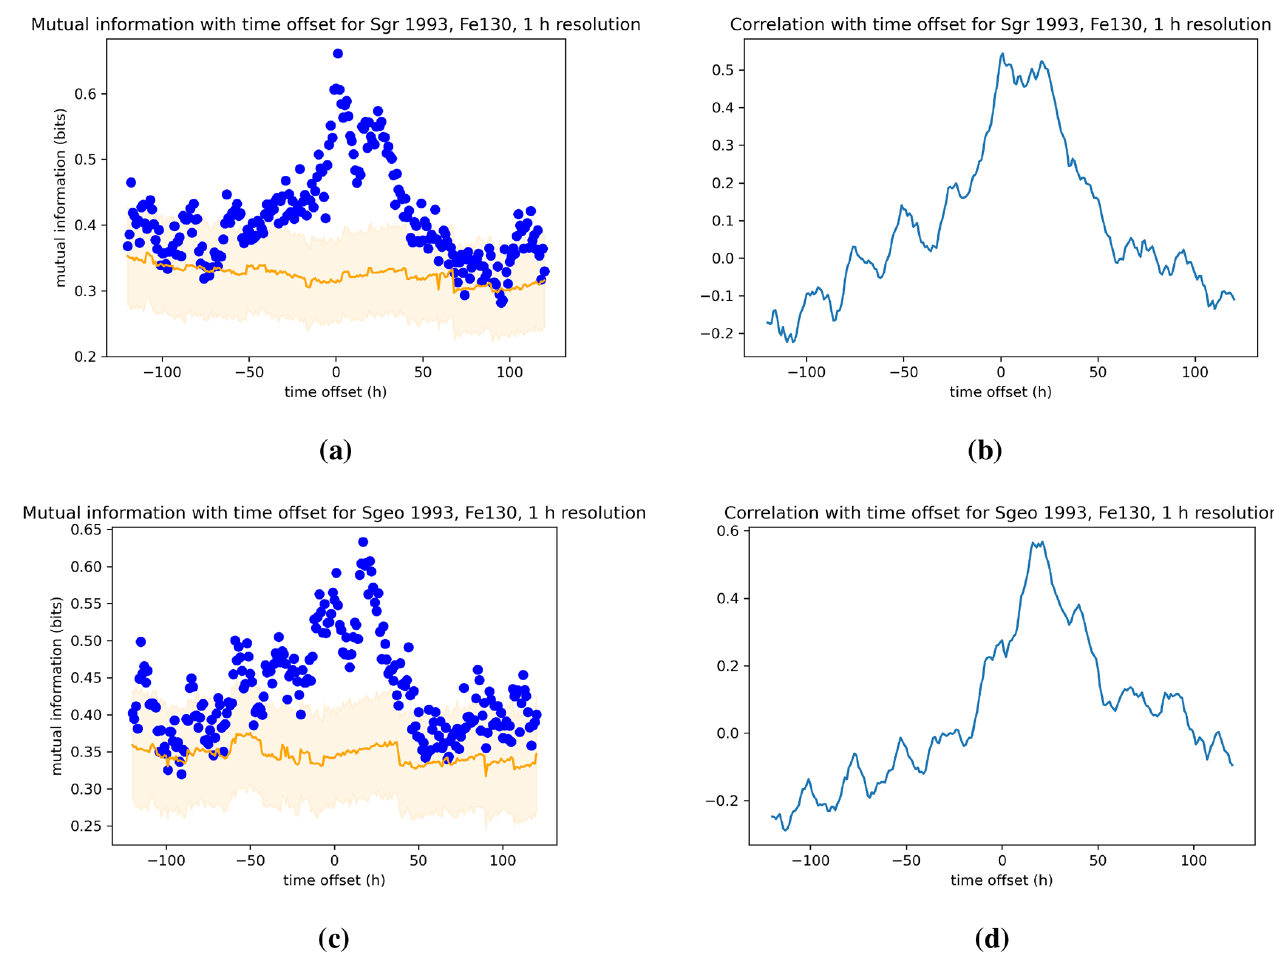
Figure 10. Same as in Fig. 8 but for the 1993 event of Rostoker et al.